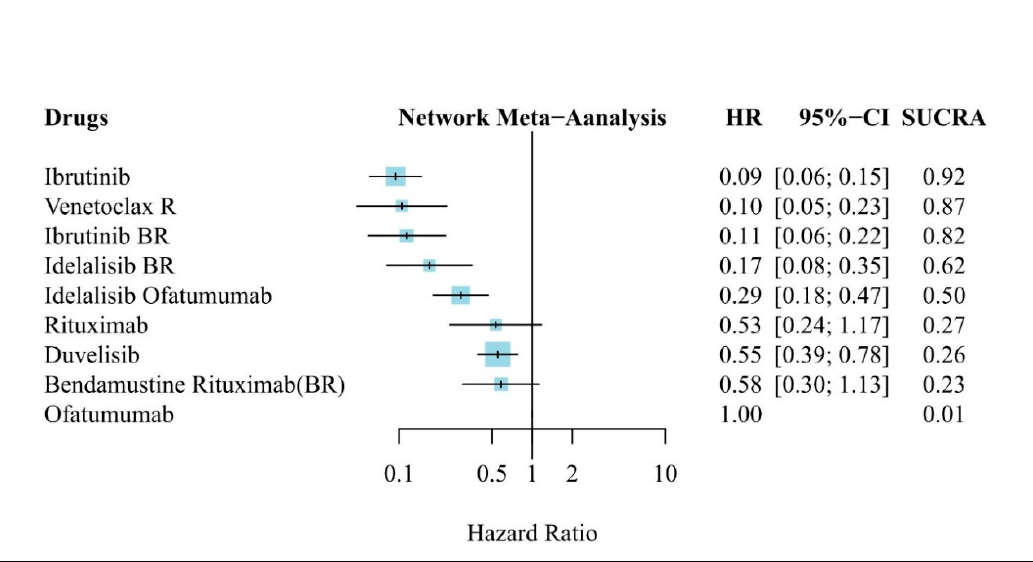
Figure 5. Network meta-analysis results of treatment efficacy in refractory/relapse (R/R) chronic lymphocytic leukemia (CLL): Forest plot of PFS in R/R CLL patients without del(17p) mutation. HR: Hazard ratio, CI: Confidence interval, SUCRA: Surface under the cumulative ranking curve, BR: Bendamustine + Rituximab, R: Rituximab